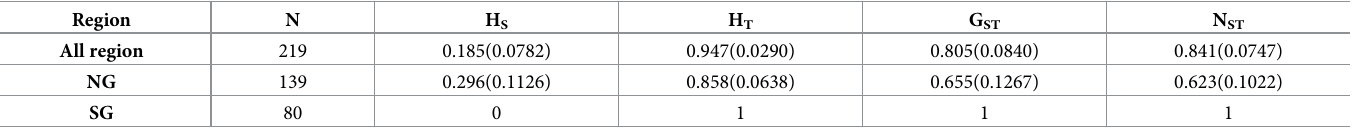
Table 2. Estimation of gene diversity (H S , H T ) and gene differentiation (G ST , N ST ) values of the total populations, the northern group (NG) and southern group (SG). Region N H S H T G ST N ST All